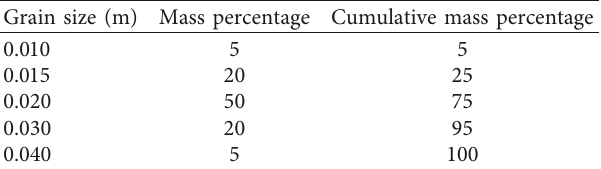
Table 5: Grain size gradation